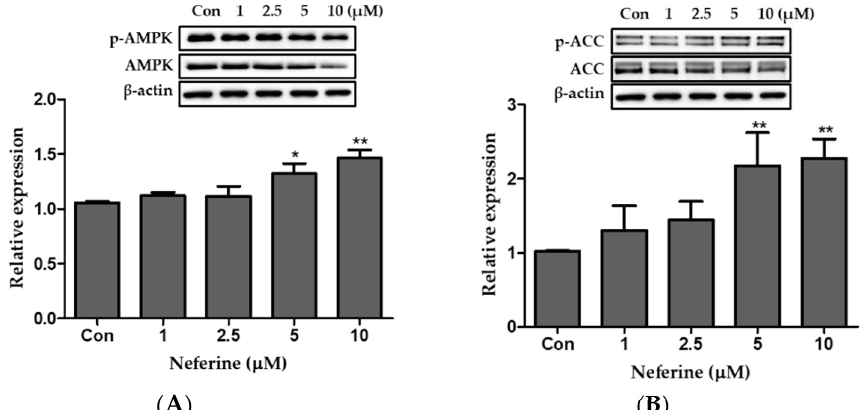
Figure 8. Effects of neferine on AMPK and ACC in primary white adipocytes. Western blot analysis was performed to evaluate the ratio of the relative protein expression levels of ( A ) p -AMPK/AMPK and ( B ) p -ACC/ACC. * p < 0.05 and ** p < 0.01 vs. Con. All data are presented as mean ± SD, and experiments were performed at least thrice. The positive control (Con) was differentiated primary white adipocytes treated with differentiation cocktail.